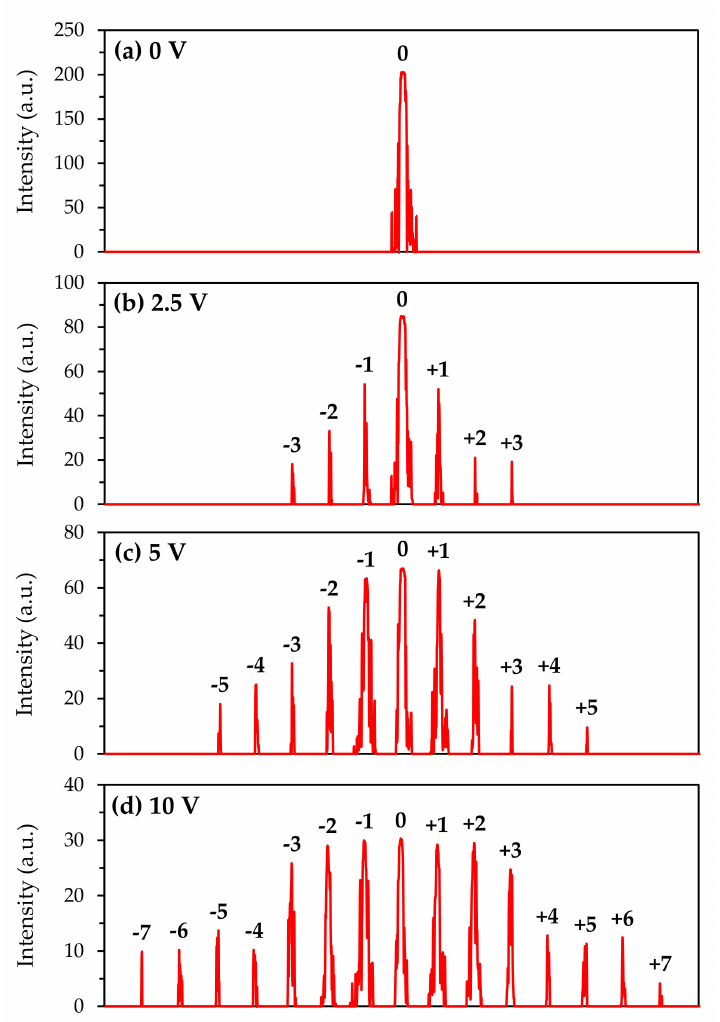
Figure 3. Spatial distributions of the di ff raction intensities of the electrically tunable grating at ( a ) 0 V, ( b ) 2.5 V, ( c ) 5.0 V, and ( d ) 10.0 V,